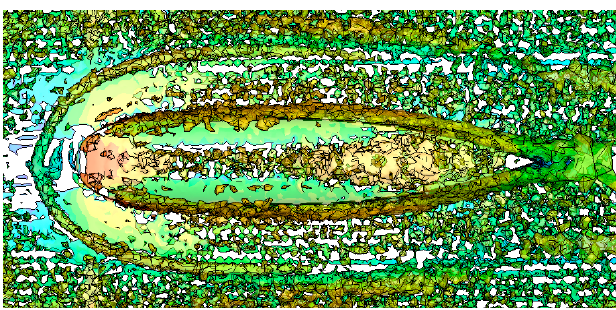
Figure 5. The diagram of the horseshoe vortex nearby the sail hull.